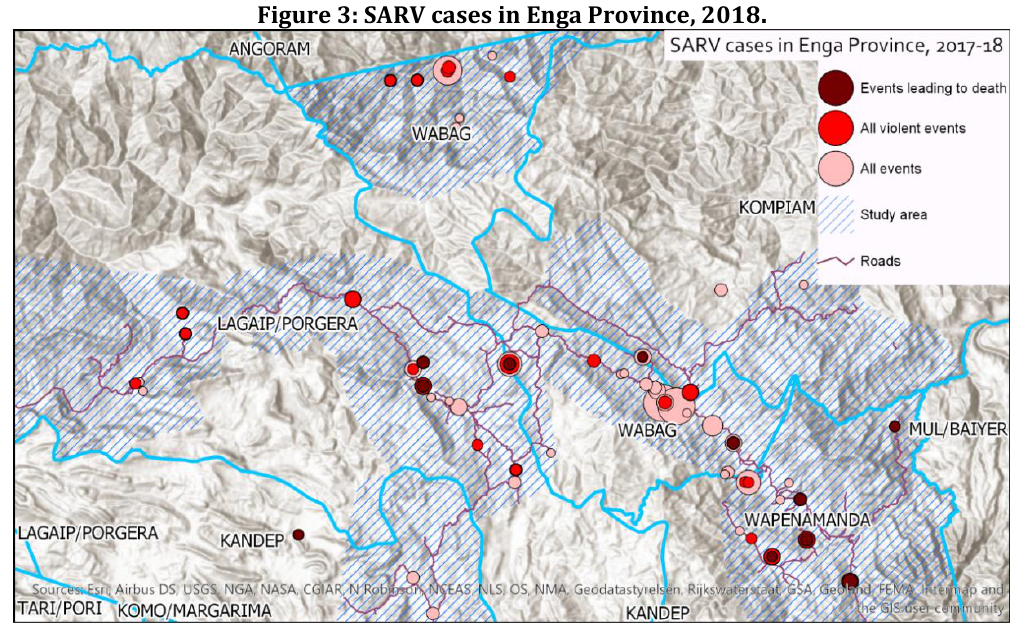
Figure 4: SARV cases in Enga Province, 2017 –